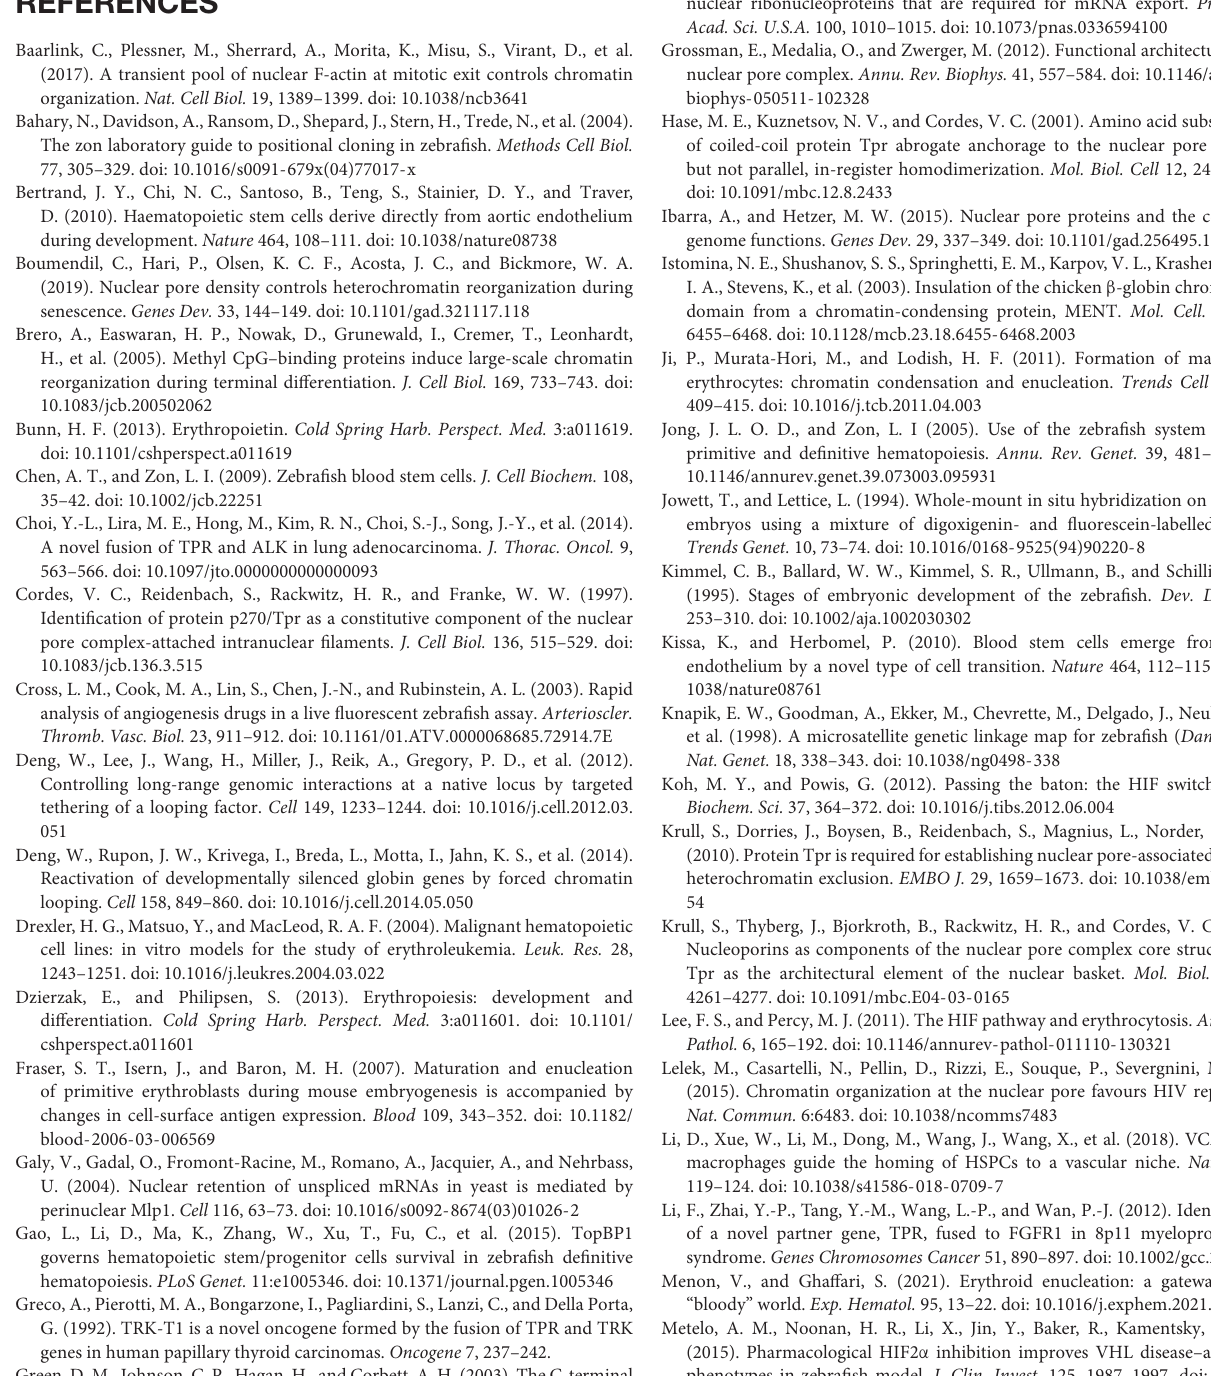
Supplementary Figure 14 | Zebrafish nup62l mutants represent similar phenotype with tprb cas 7 mutants. (A,B) WISH analysis of ae1-globin show the increased expression in nup62l mutants compared with sibling at 3.5 dpf. The number and percentage of het-het incross embryos with the in situ pattern in a clutch are listed at the bottom of the mutant